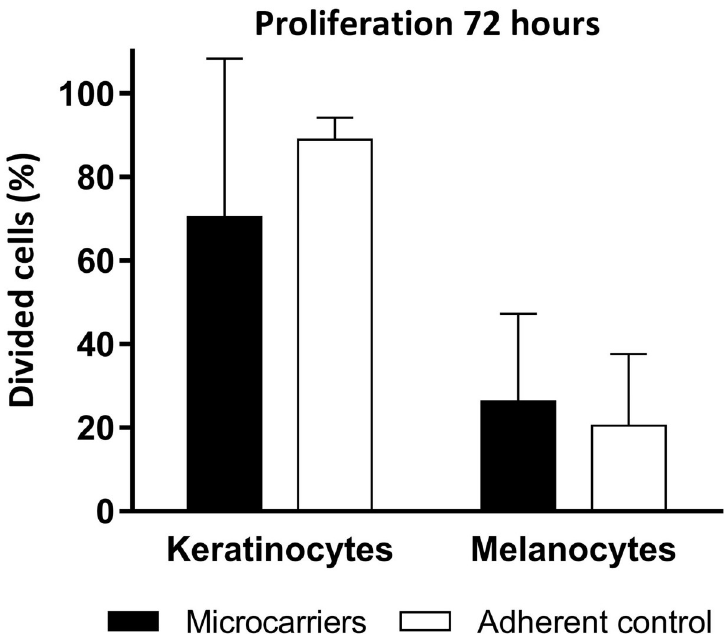
Fig 3. Proliferation of CFSE-stained keratinocytes and melanocytes on microcarriers. Flow cytometric analyses of 5 (6) carboxyfluorescein-N-hydroxysuccinimidyl ester (CFSE)-staining in keratinocytes and melanocytes cultured on microcarriers in spinner flask culture and on cell culture polystyrene. No significant difference in percentage of divided cells was found between the culture methods (mean ± SD, p > 0.05, n = 3).